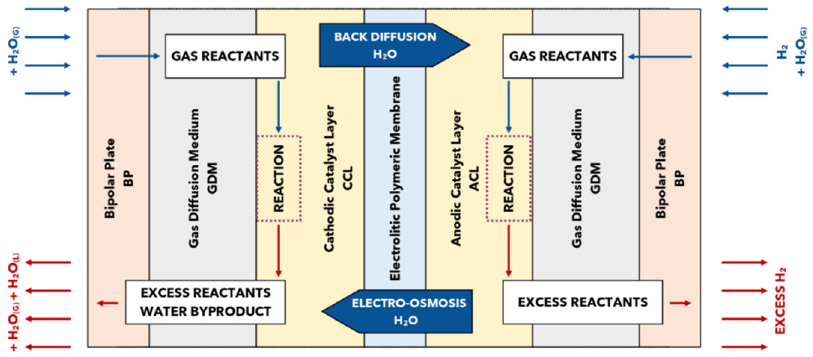
Figure 2. Schematic representation of a functioning PEM fuel cell with the gas and liquid flows.